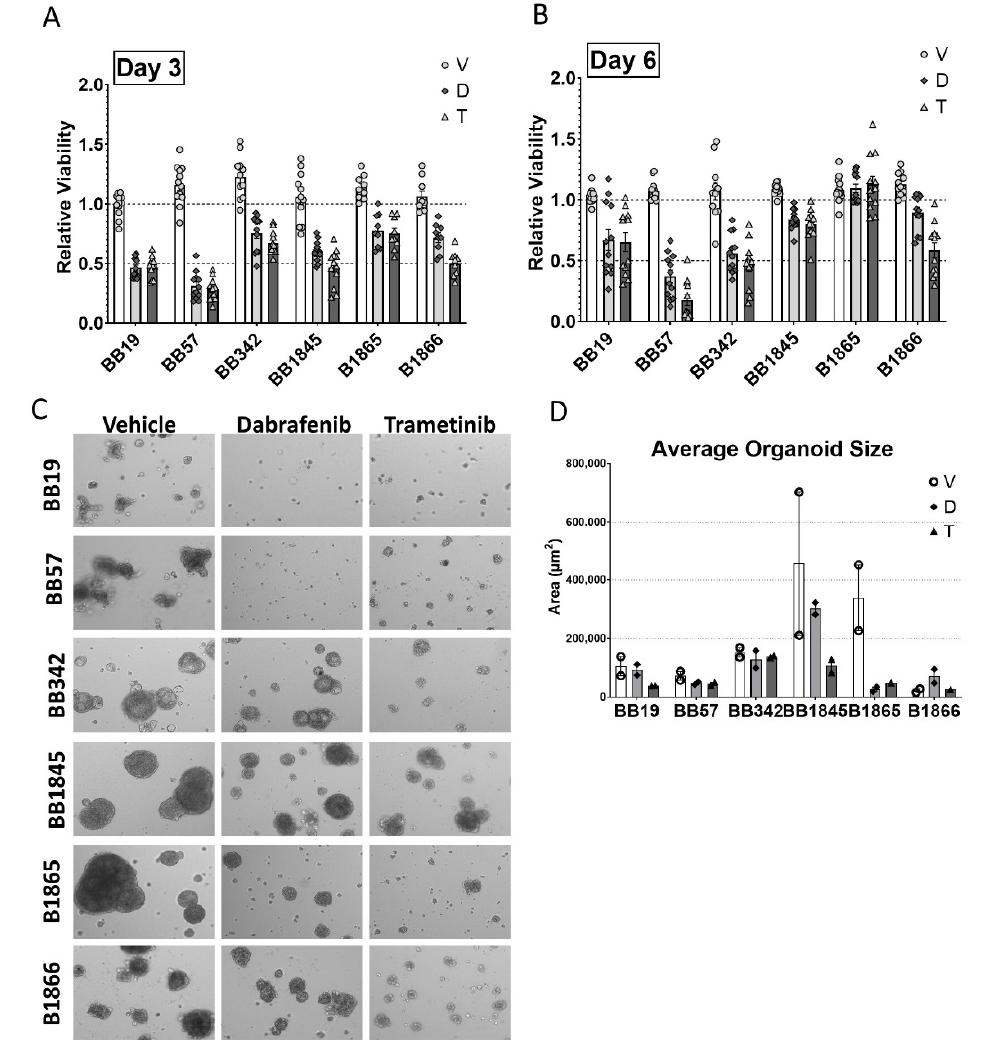
Figure 4. Growth-suppressive effects of targeted BRAF and MEK1/2 inhibition in Braf V600E+/ − /Pten +/ − /TPO-Cre cell lines in 2D monolayer and 3D organoid cultures. ( A ) Summary plot showing viability of novel cell lines in 2D culture following treatment with the BRAF inhibitor Dabrafenib (D), MEK1/2 inhibitor Trametinib (T) or DMSO vehicle (V) compared to control cells grown in standard culture medium. Cells were treated with selected concentrations of each inhibitor or vehicle for 3 days prior to analysis using CellTiter Glo Luminescent Cell Viability Assay. N = 3 independent experiments in triplicate. ( B ) Summary plot showing viability of tumor cell lines treated with inhibitors as in ( A ) for 6 days prior to analysis using CellTiter Glo Luminescent Cell Viability Assay. ( C ) Representative images of novel cell lines grown in 3D organoid culture and treated with the BRAF inhibitor Dabrafenib, MEK1/2 inhibitor Trametinib or DMSO vehicle for 10 days. Images were captured at 4× magnification. ( D ) Quantitation of average organoid area of novel cell lines treated as in ( C ).